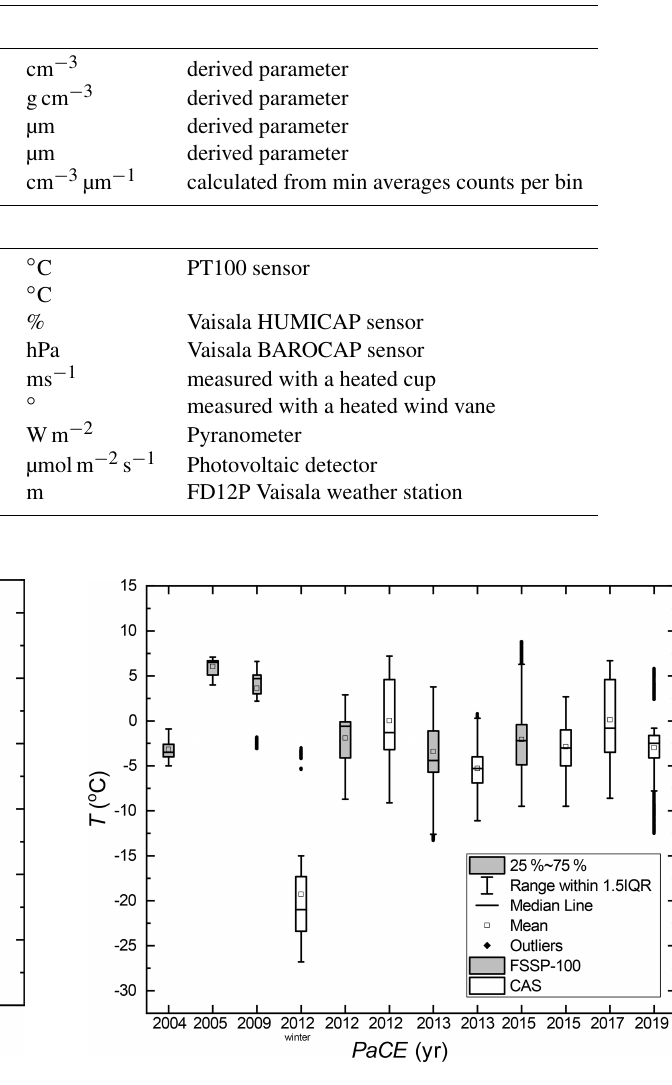
Figure 4. Hours of observation data collected for each PaCE cam- paign when the FSSP-100 and CAPS ground setups were opera- tional.